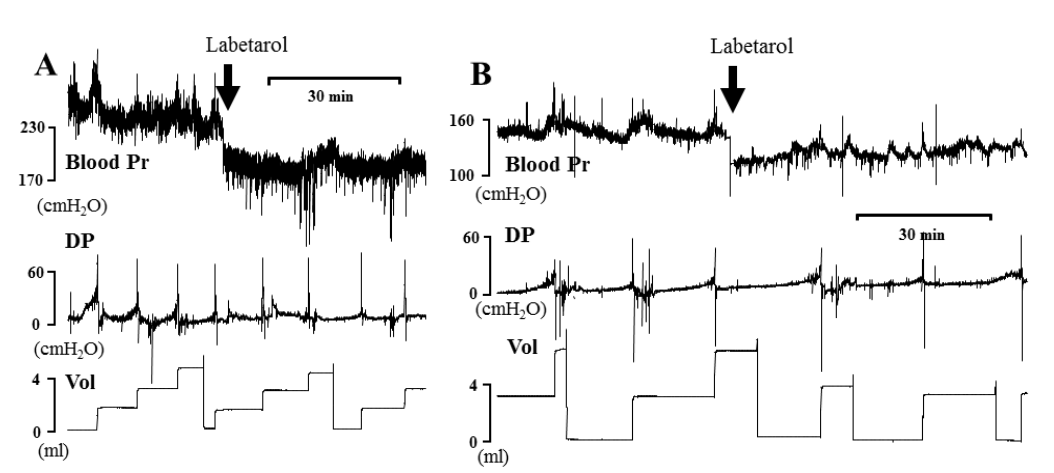
Figure 2. Representative cystometrogram showing simultaneous arterial pressures, detrusor pressures, and micturition volume before and after the arterial injection of 5 mg·kg −1 labetalol in conscious SHRs ( A ) and Wistar rats ( B ). Pr: pressure; DP: detrusor pressure; Vol: